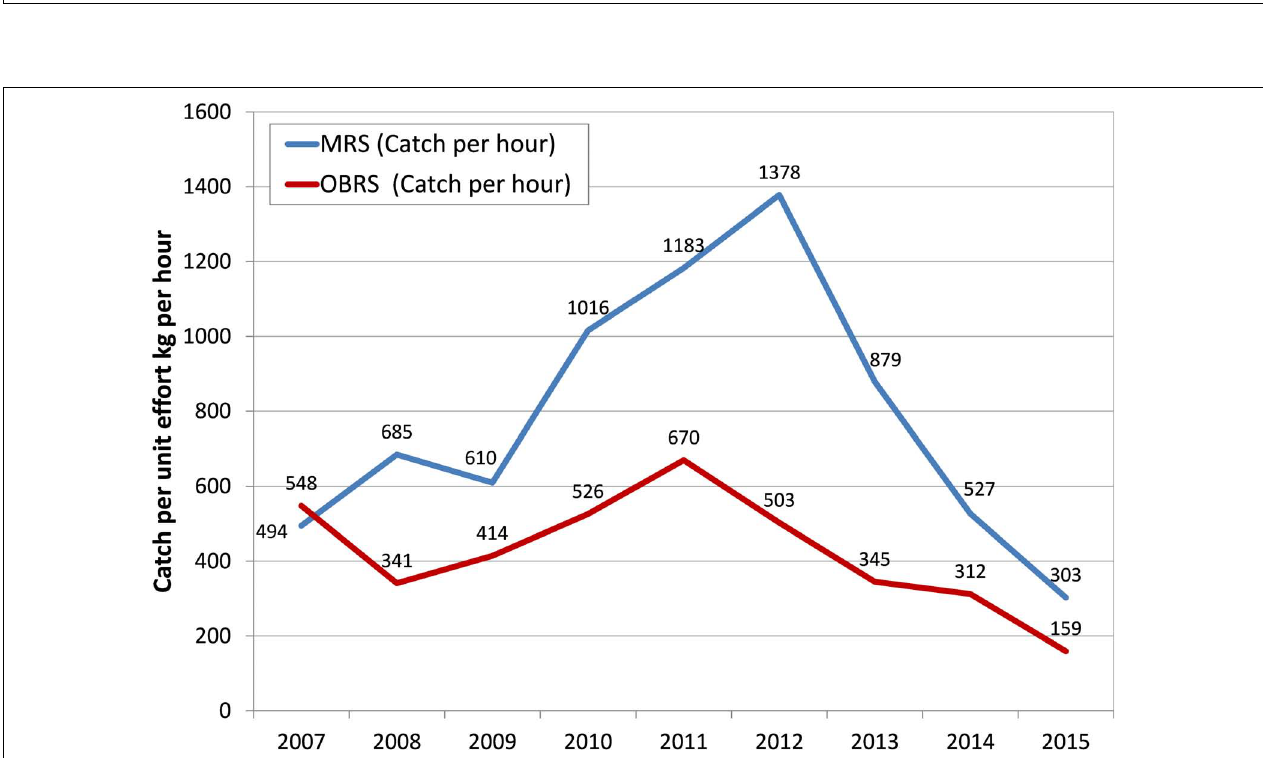
FIGURE 4 | Catch rate (in kg per hour) of oil sardines in the two principal gears MRS and OBRS.